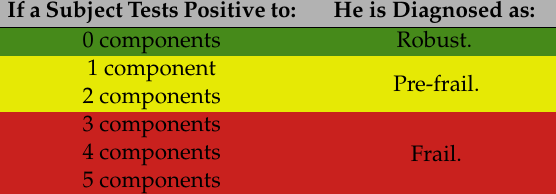
Table 1. The phenotypic model for frailty involves the assessment of five different components (weight loss, exhaustion, weakness, slowness, and low physical activity); and then diagnosing the subject as robust, pre-frail, or frail, according to the number of components that resulted positive in the tests: robust (green rows) for zero components, pre-frail (yellow rows) for 1 or 2 components, or frail (red rows) for 3, 4, or 5 components. If a Subject Tests Positive to: He is Diagnosed as: